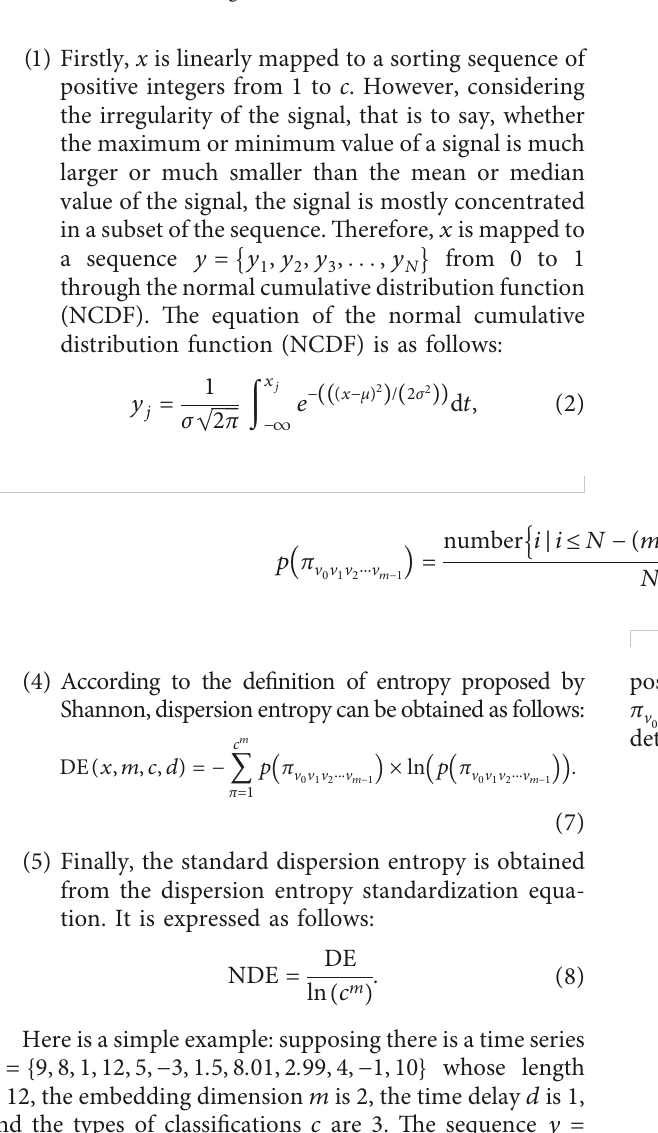
Figure 2: Multiscale coarse granulation of the time series with scale